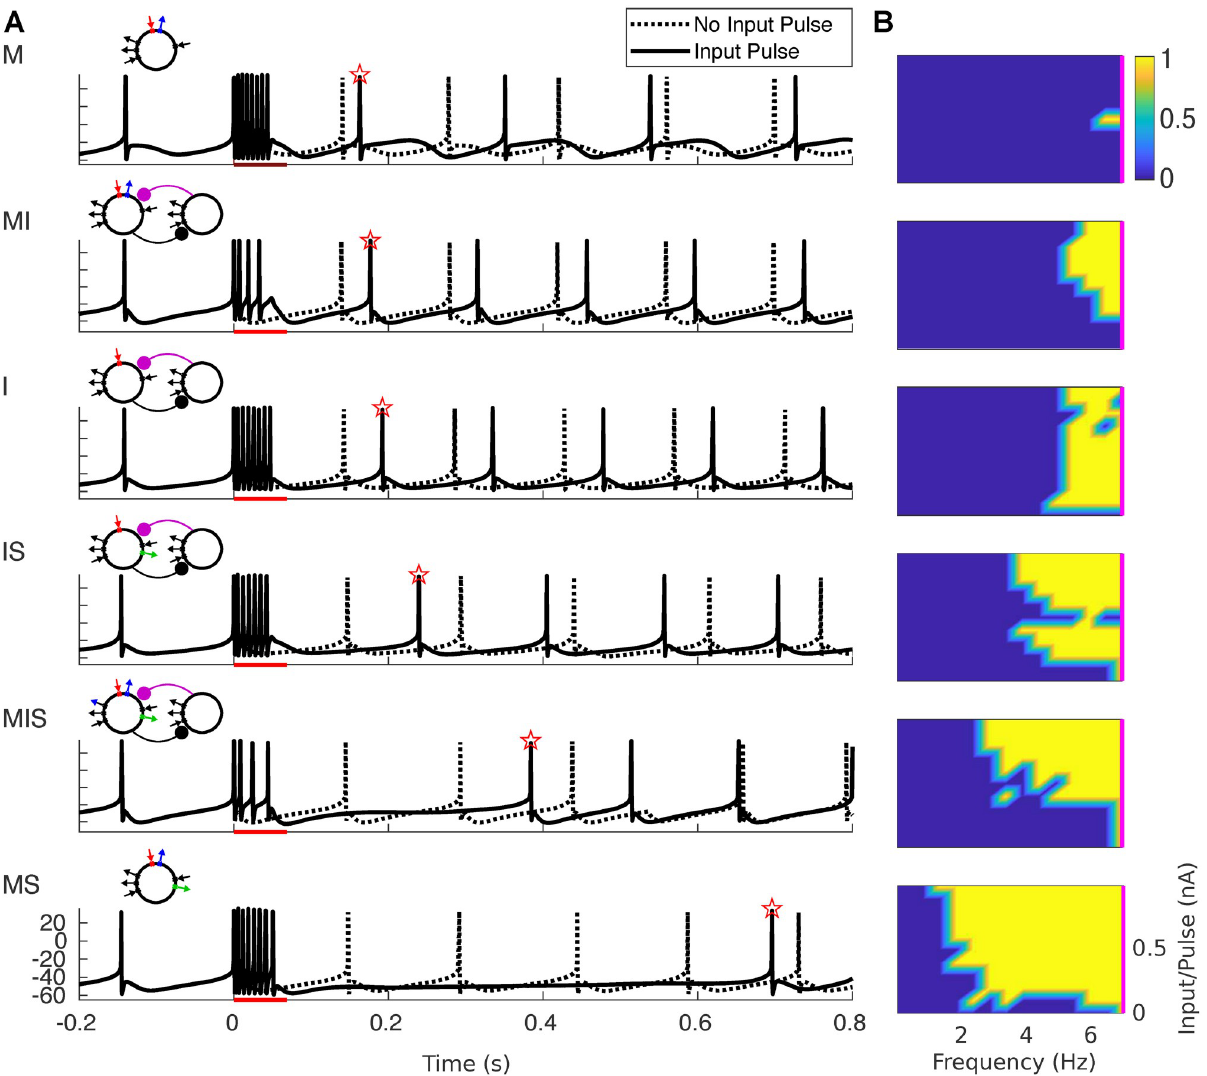
Fig 7. Delay of spiking in response to single pulse determines phase-locking to slow inputs. (A) Voltage traces are plotted for simulations both with (solid lines) and without (dotted lines) an input pulse lasting 50 ms. Red bar indicates the timing of the input pulse; red star indicates the first post-input spike. (B) The phase-locking value is estimated from the response to a single input pulse using Eq (1). Frequency was calculated as 1/(4 � (pulse duration)), where pulse duration is in seconds. Input per pulse was calculated by integrating pulse magnitude. The magenta line indicates 7 Hz.